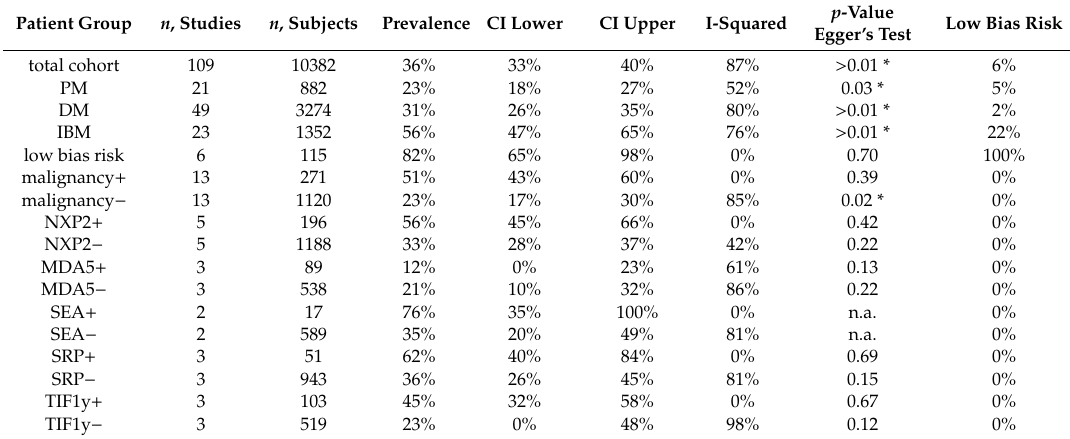
Table 1. The estimate of the pooled prevalence, the 95% confidence interval (CI), the number of included studies and subjects, I 2 as measure for heterogeneity, p -value of the Egger’s test and percentage of studies with low risk of bias for all meta-analyses.